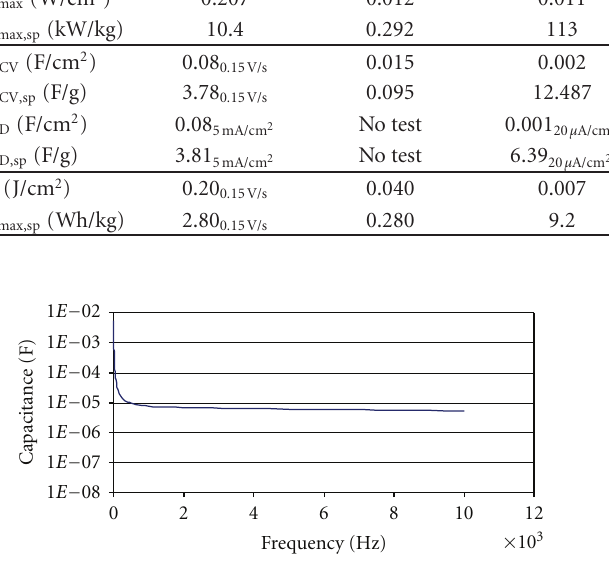
Figure 5: Capacitance as a function of frequency from impedance testing of EDLC CWF-GF/F capacitor between 10 kHz and 1Hz; each carbon electrode has an area of 2 cm 2 and mass of